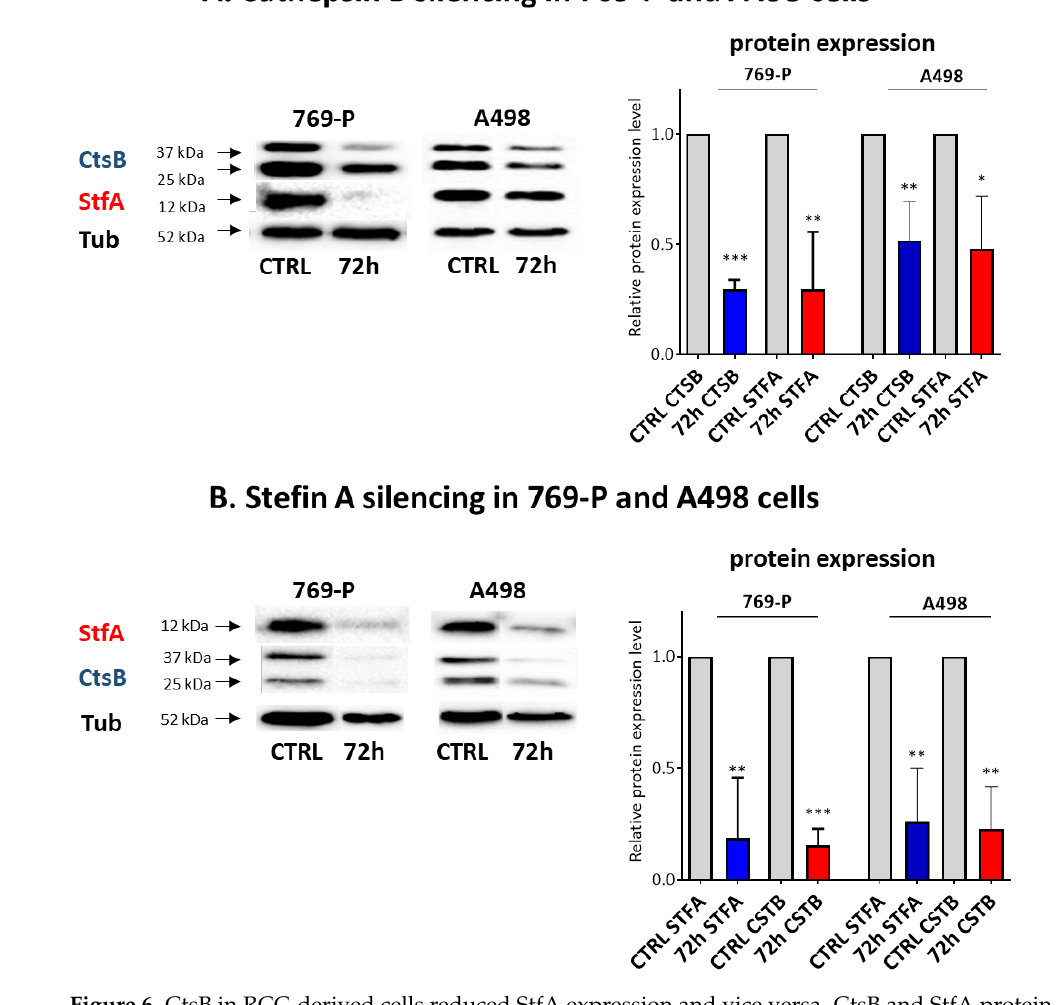
Figure 6. CtsB in RCC-derived cells reduced StfA expression and vice versa. CtsB and StfA protein expression was determined by Western blotting in 769-P and A498 after transfection with ( A ) sh CTSB and ( B ) sh STFA constructs compared to control cells treated with empty shRNA. The data were normalized against tubulin used as a housekeeping protein. All values were the average of at least three biological replicates, and the data represent the mean ± SD. The U Mann–Whitney test analyzed significance; * p < 0.05; ** p < 0.01, *** p < 0.001 relative to control.